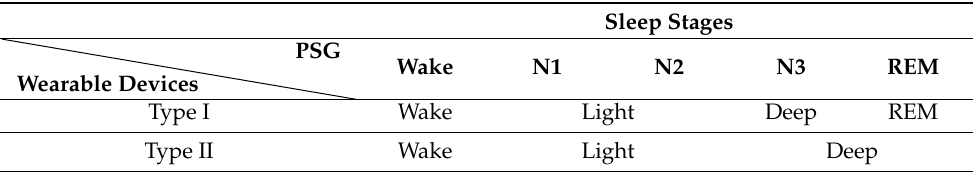
Table 1. Methods of categorizing sleep staging scored by wearable devices and the corresponding sleep stages according to AASM guidelines.